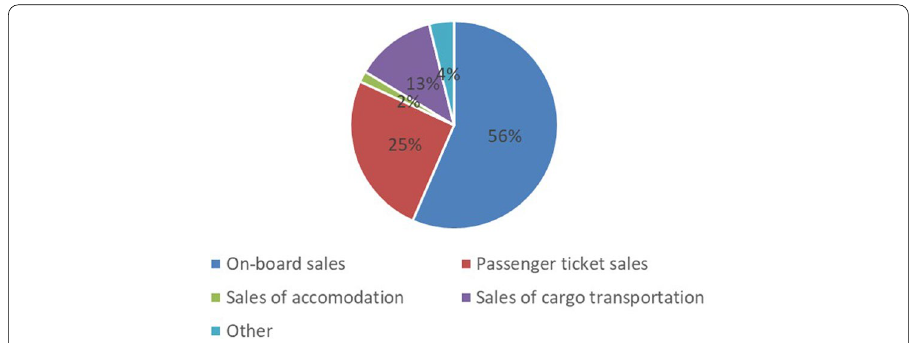
Fig. 5 Tallink’s income from different geographical segments. Source : Tallink (2021)